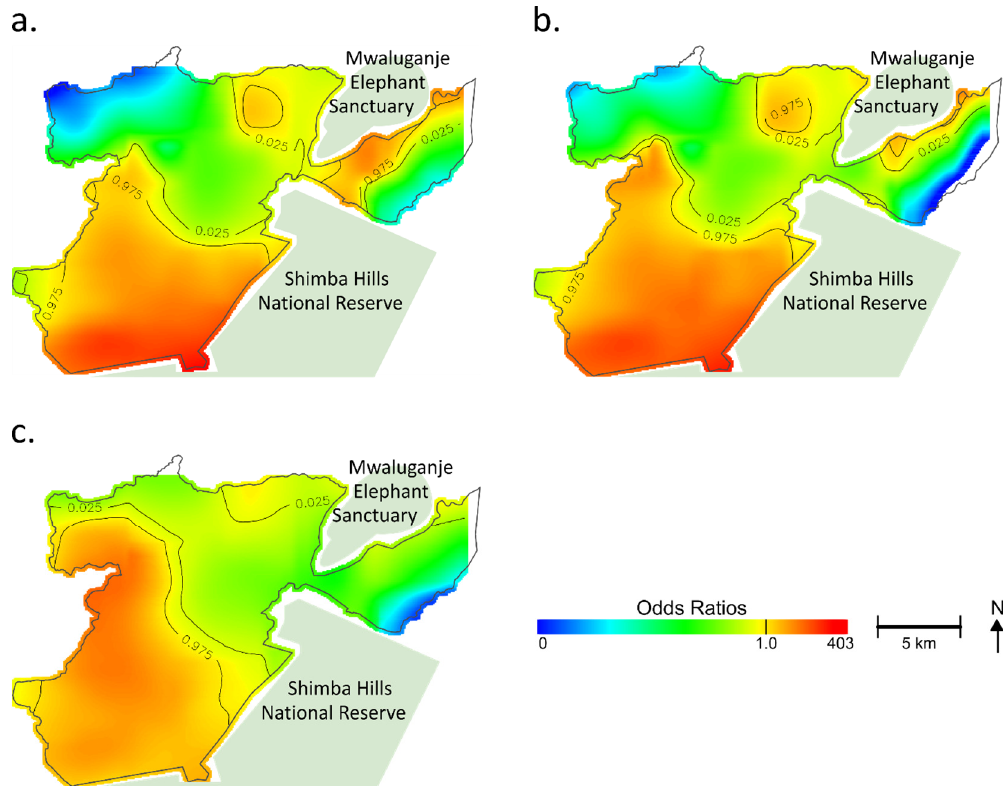
Figure 2. Geographical distribution of estimated odds ratios of tungiasis in the household. For easy comparison, a color band is fixed in an arbitrary range. Regions at the edge of the study area and no data or regions with odds ratios (ORs) outside the fixed range are shown in white. Based on the permutation test, contour lines indicate areas with significantly increased or decreased ORs. ( a ) Unadjusted; ( b ) Model 1 adjusted for the number of children per household, the number of elderly per household, the number of males per household, type of floor, type of wall, type of roof, type of toilet, Normalized Difference Vegetation Index (NDVI), land cover, Topographic Wetness Index (TWI), elevation, soil pH, soil texture, soil organic carbon content, aluminum content in the soil, and iron content in the soil; ( c ) Model 2 adjusted for the number of children per household, the number of elderly per household, the number of males per household, type of floor, type of wall, type of roof, type of toilet, NDVI, land cover, TWI, elevation, soil pH, soil texture, soil organic carbon content, aluminum content in the soil, iron content in the soil, and distance to the nearest animal reserve area.